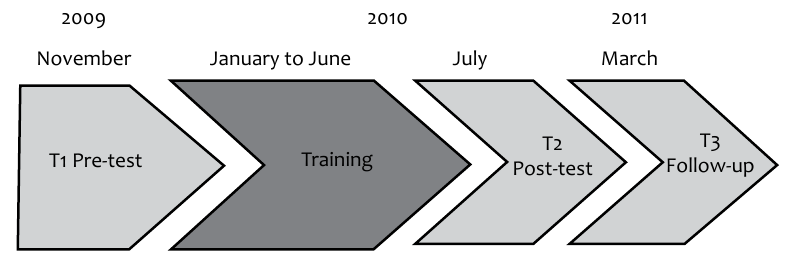
Figure 8: Course of the study with three measuring